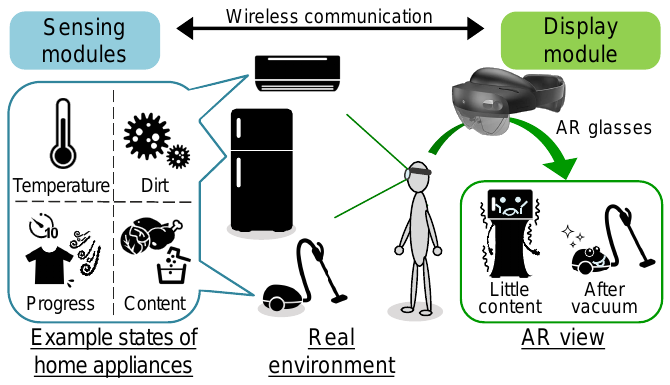
Figure 1. System